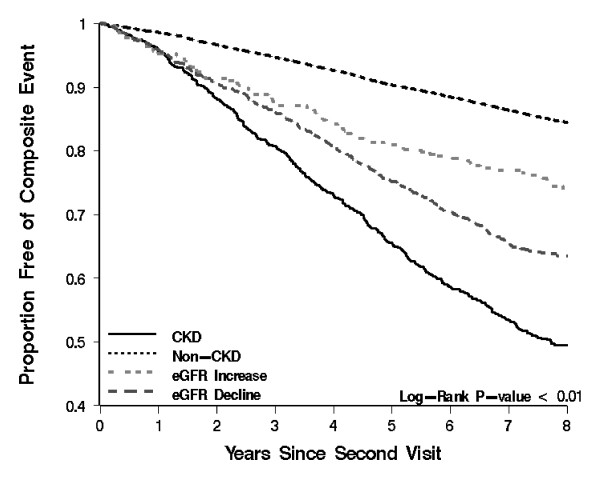
Kaplan-Meier curves presenting the relationship between kidney function groups and Composite outcomes.